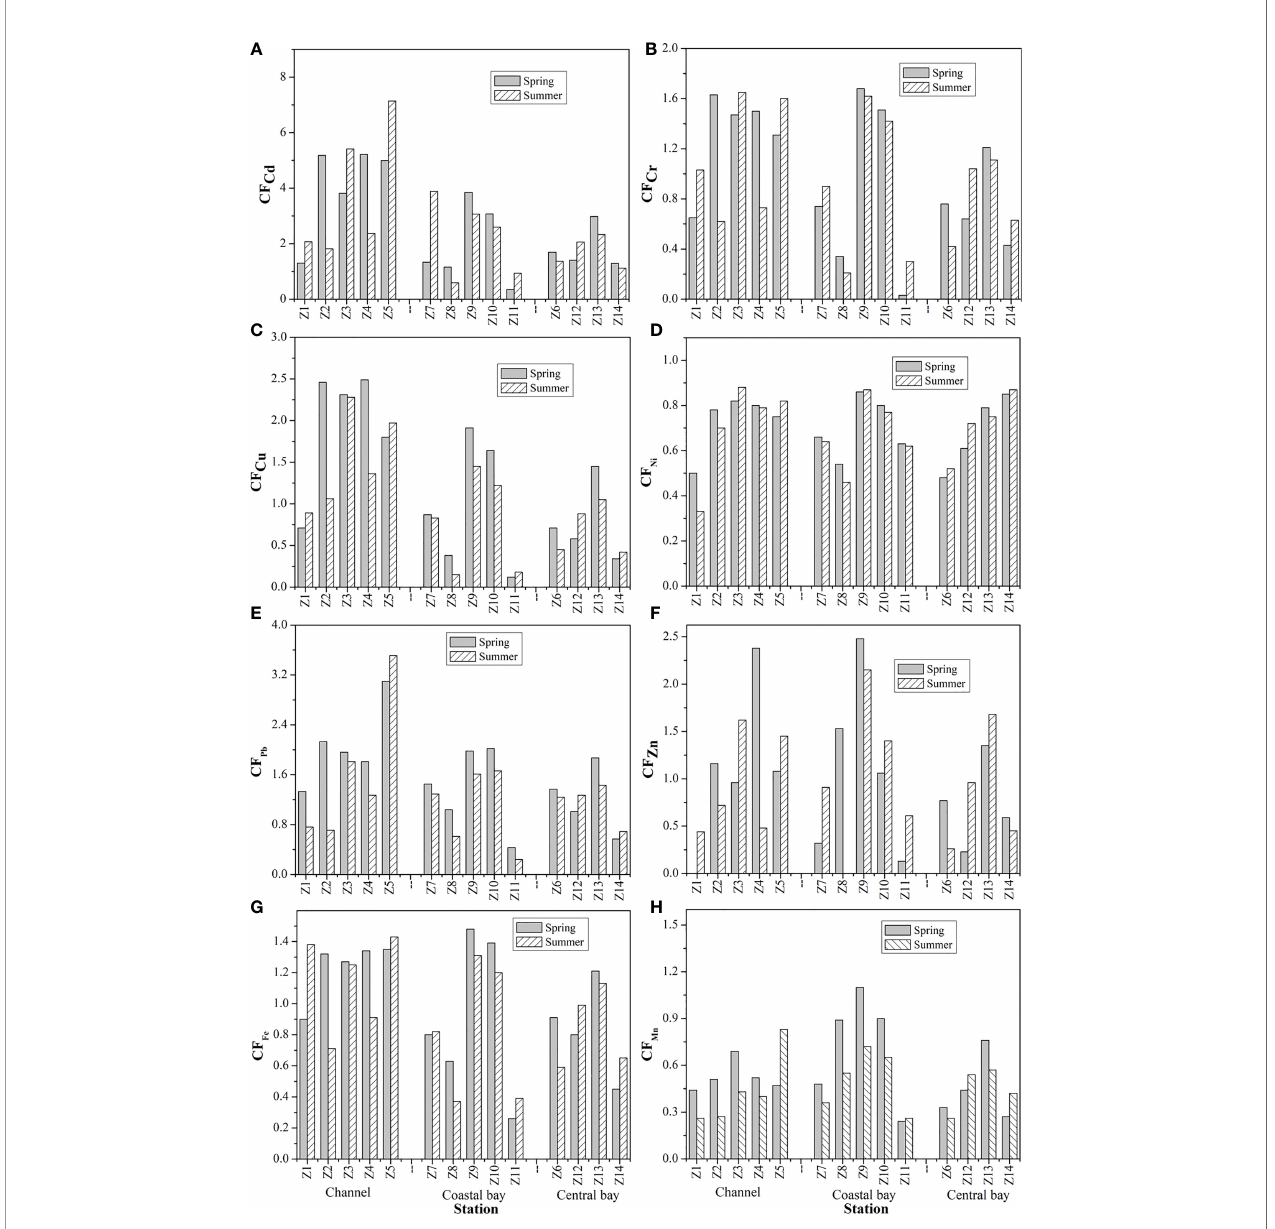
FIGURE 6 | Distributions of contamination factor (CF) for Cd (A) , Cr (B) , Cu (C) , Ni (D) , Pb (E) , Zn (F) , Fe (G) and Mn (H) in surface sediments of Zhanjiang